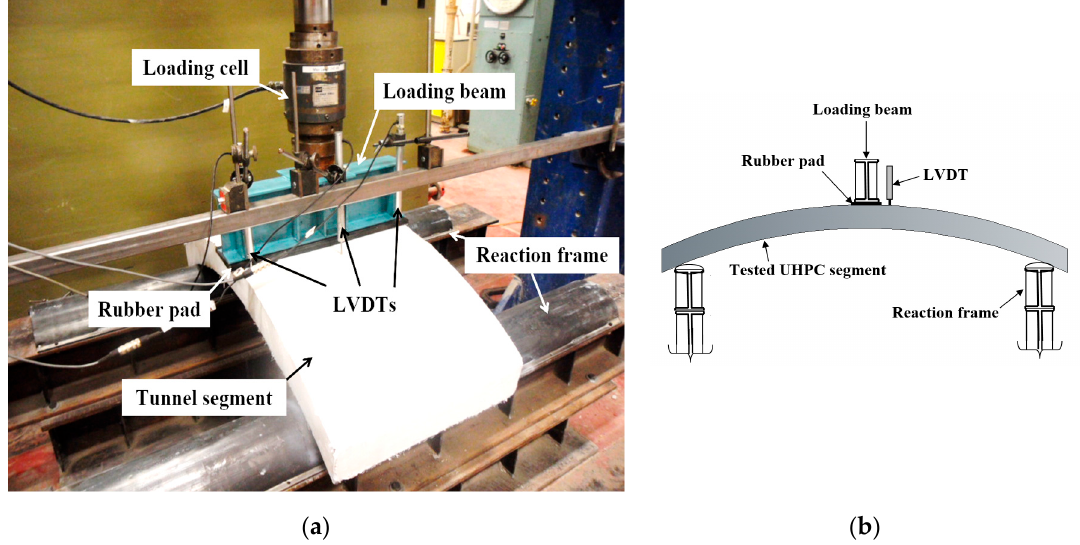
Figure 4. Flexural test setup of UHPC lining segment: ( a ) Experimental test setup; ( b ) Schematic test setup (side view).